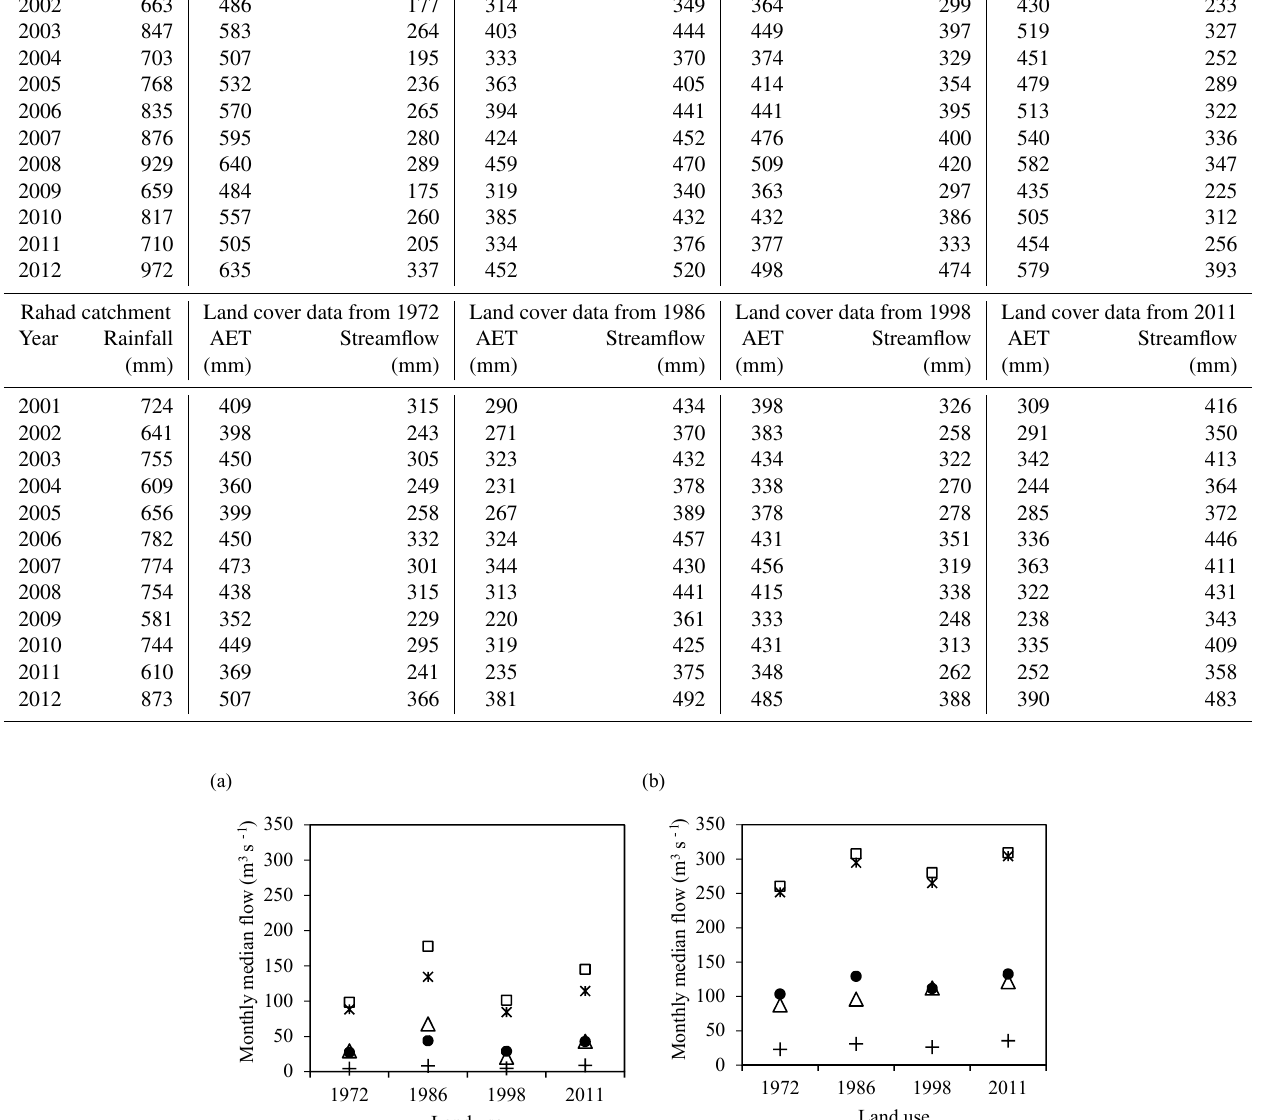
Figure 11. The monthly median flow (a) for Rahad River and (b) for Dinder